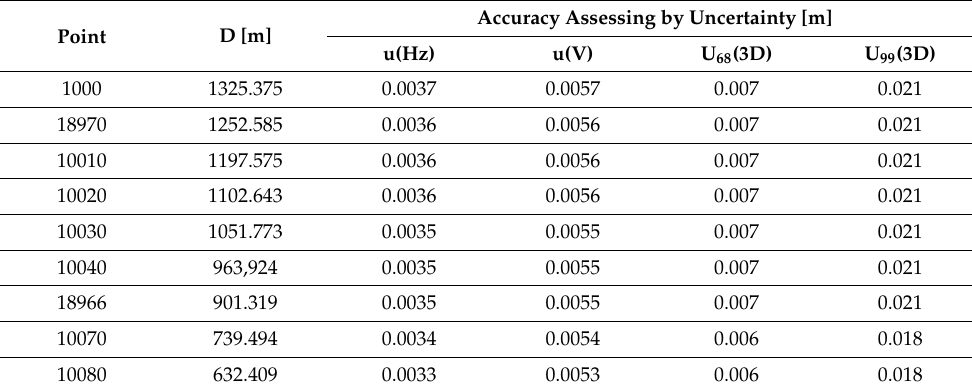
Table 2. Expected accuracy of rapid static GNSS surveys.